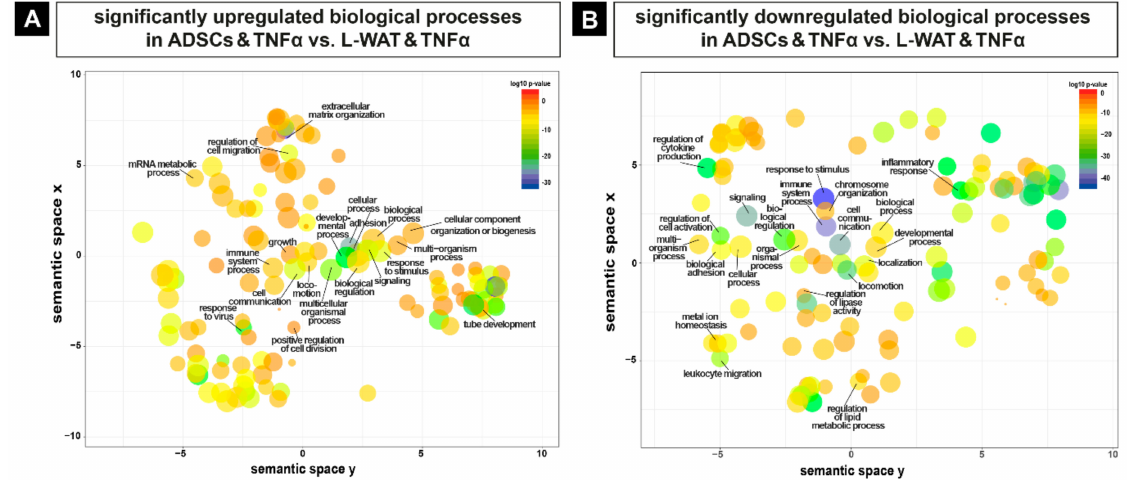
Figure 5. Significantly changed biological pathways in ADSCs and L-WAT after incubation with TNF α . Di ff erential gene expression analysis revealed hundreds of significant upregulated ( A ) and downregulated ( B ) biological pathways in ADSCs treated with TNF α , when compared to L-WAT treated with TNF α